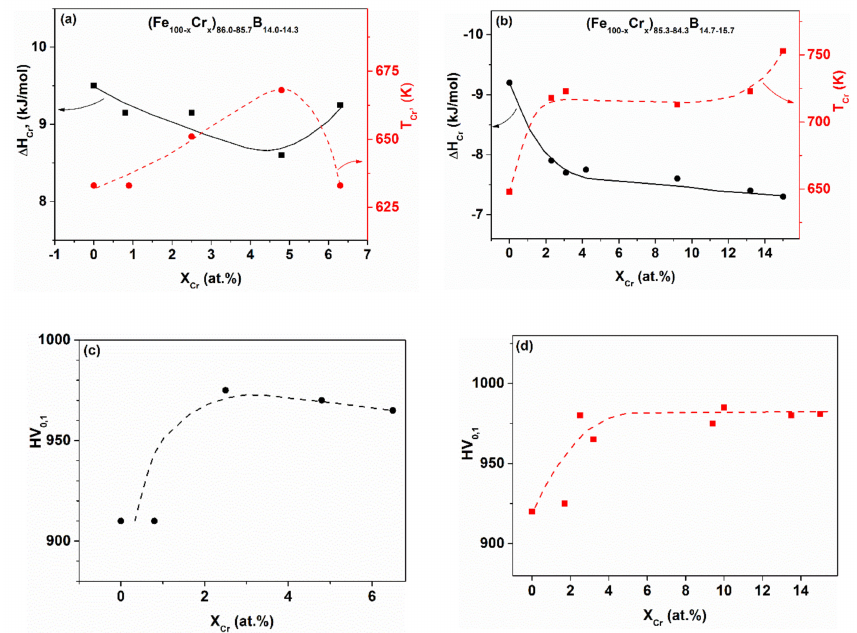
Figure 7. Crystallization enthalpies ( ∆ H cryst ) and temperatures, ( T cryst ) versus Cr content in two independent series of hypo-eutectic Fe-Cr-B glasses ( a , b ), and the corresponding change of micro-hardness (HV) ( c , d ). Adopted from [50], with permission from Elsevier,